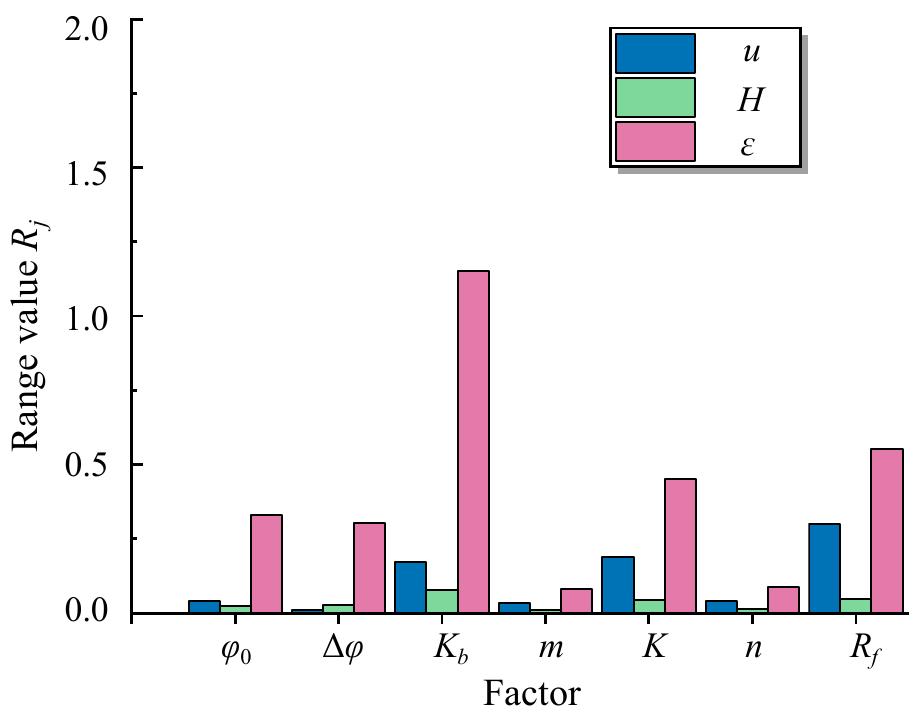
Figure 10. Sensitivity of each test index for the reservoir bottom backfill zone.